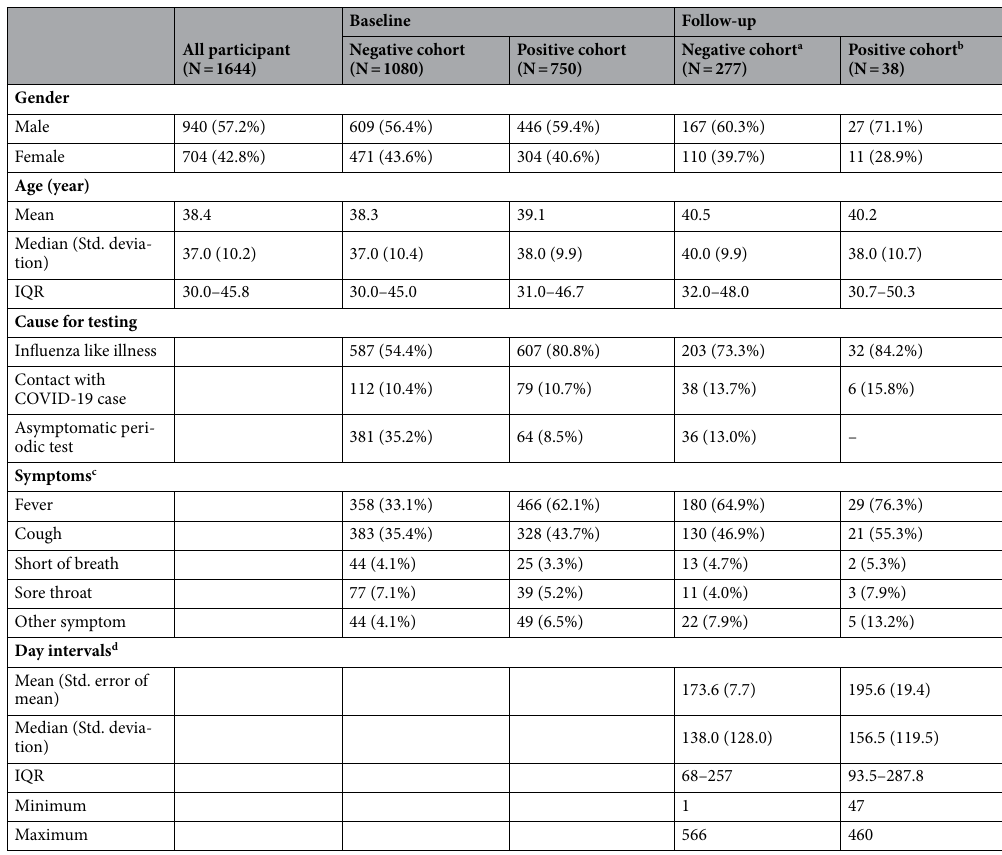
Table 1. Characteristics of study participants by baseline cohort allocation and follow-up. a First infections. b Reinfections. c Symptomatic case. d During